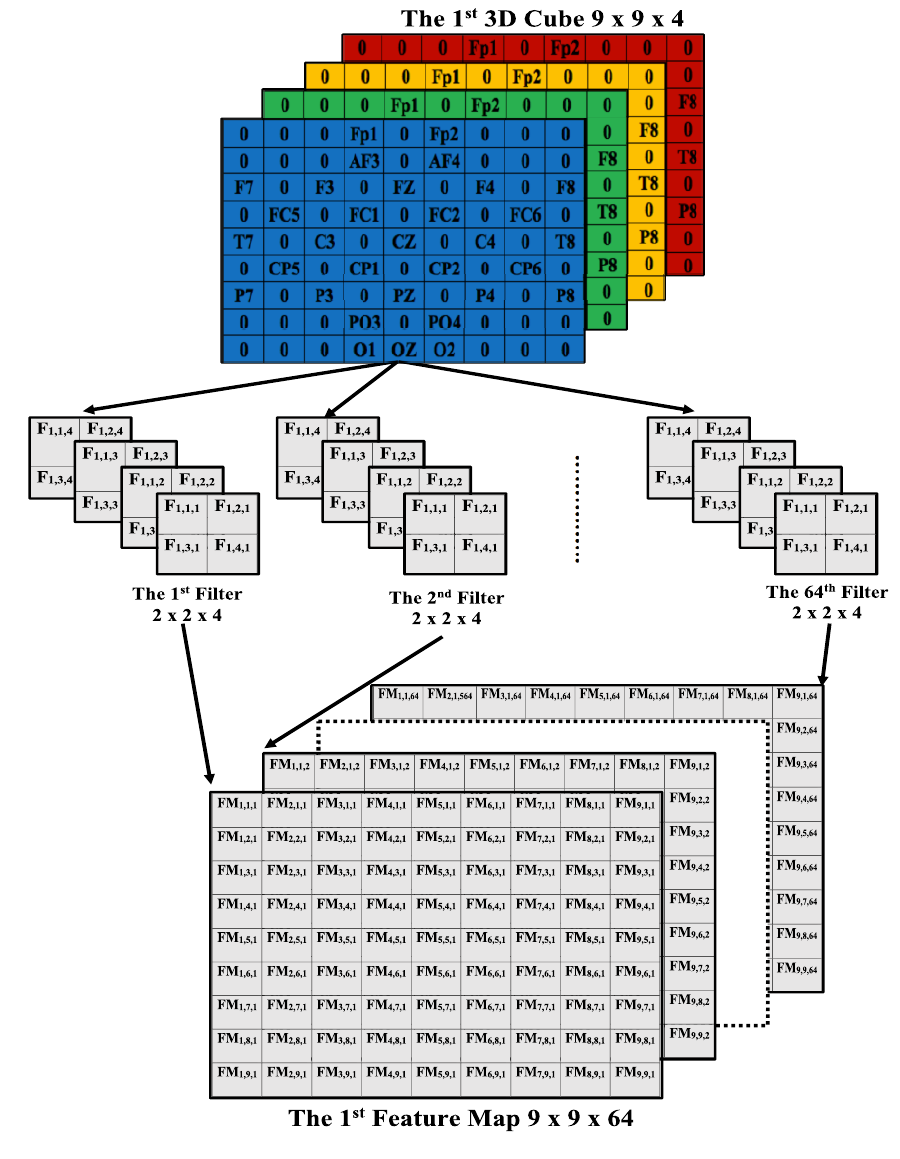
Figure 5. The illustration of the first Continuous Convolution